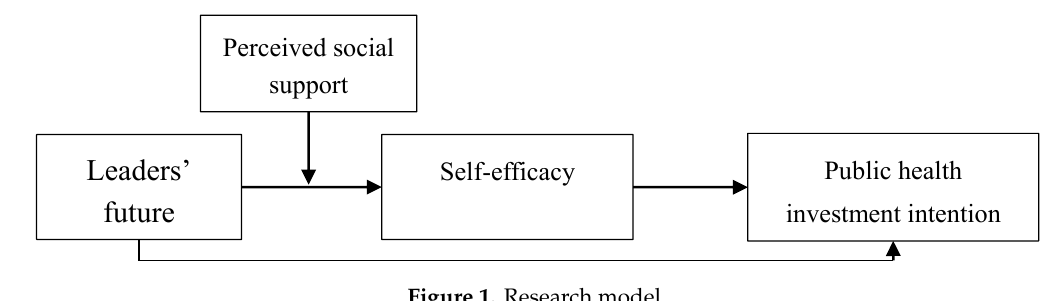
Figure 1. Research Figure 1. Research model.